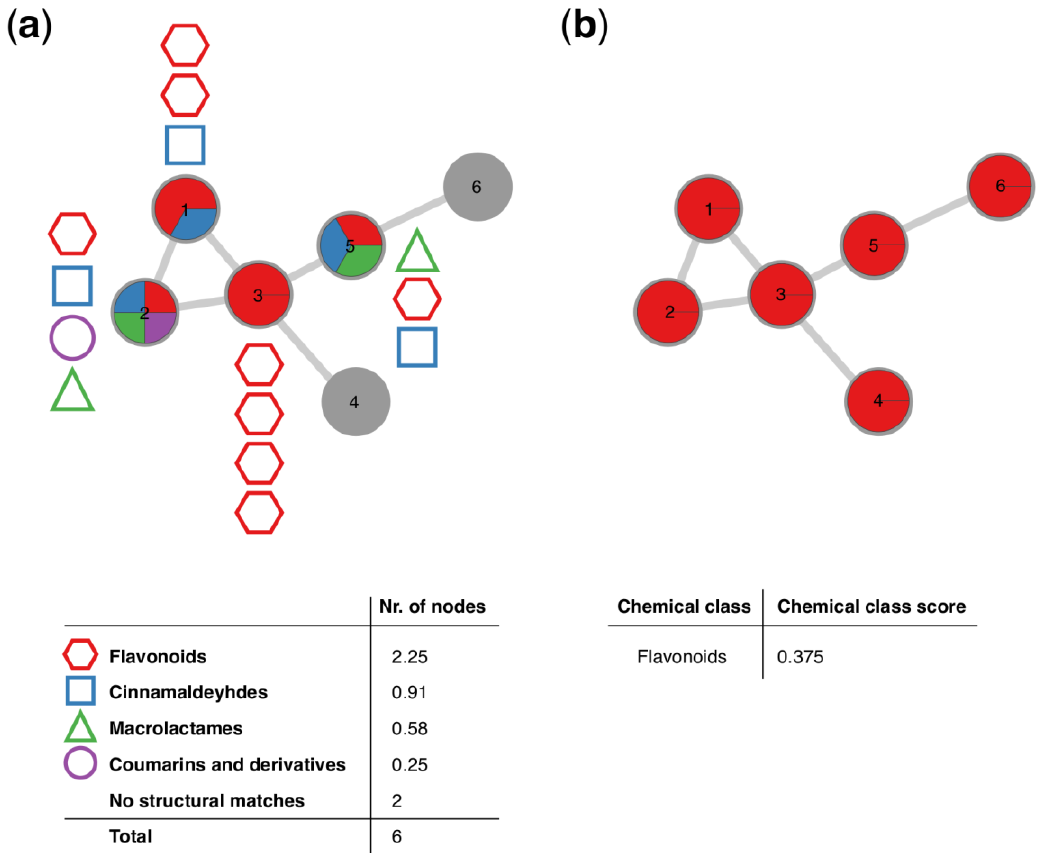
Figure 2. Schematic overview of how the chemical classification score is calculated and visualized within a molecular family. ( a ) Schematic overview of hypothetical structural annotations within a molecular family consisting of 6 nodes. Out of the 6 nodes, chemical structural information could be retrieved for 4, where each node can consist of structural annotations to multiple di ff erent (e.g., node 2) or identical (e.g., node 3) chemical classes. The total number of nodes per chemical class retrieved is calculated and the most abundant chemical class is assigned to the molecular family, resulting in ( b ). Schematic overview of the molecular family shown in ( a ), classified as ‘flavonoids’ at the chemical class level by MolNetEnhancer, with a score of 0.375, translating to the majority of the putative structural annotations within this molecular family (2.25) belong to the flavonoid structural